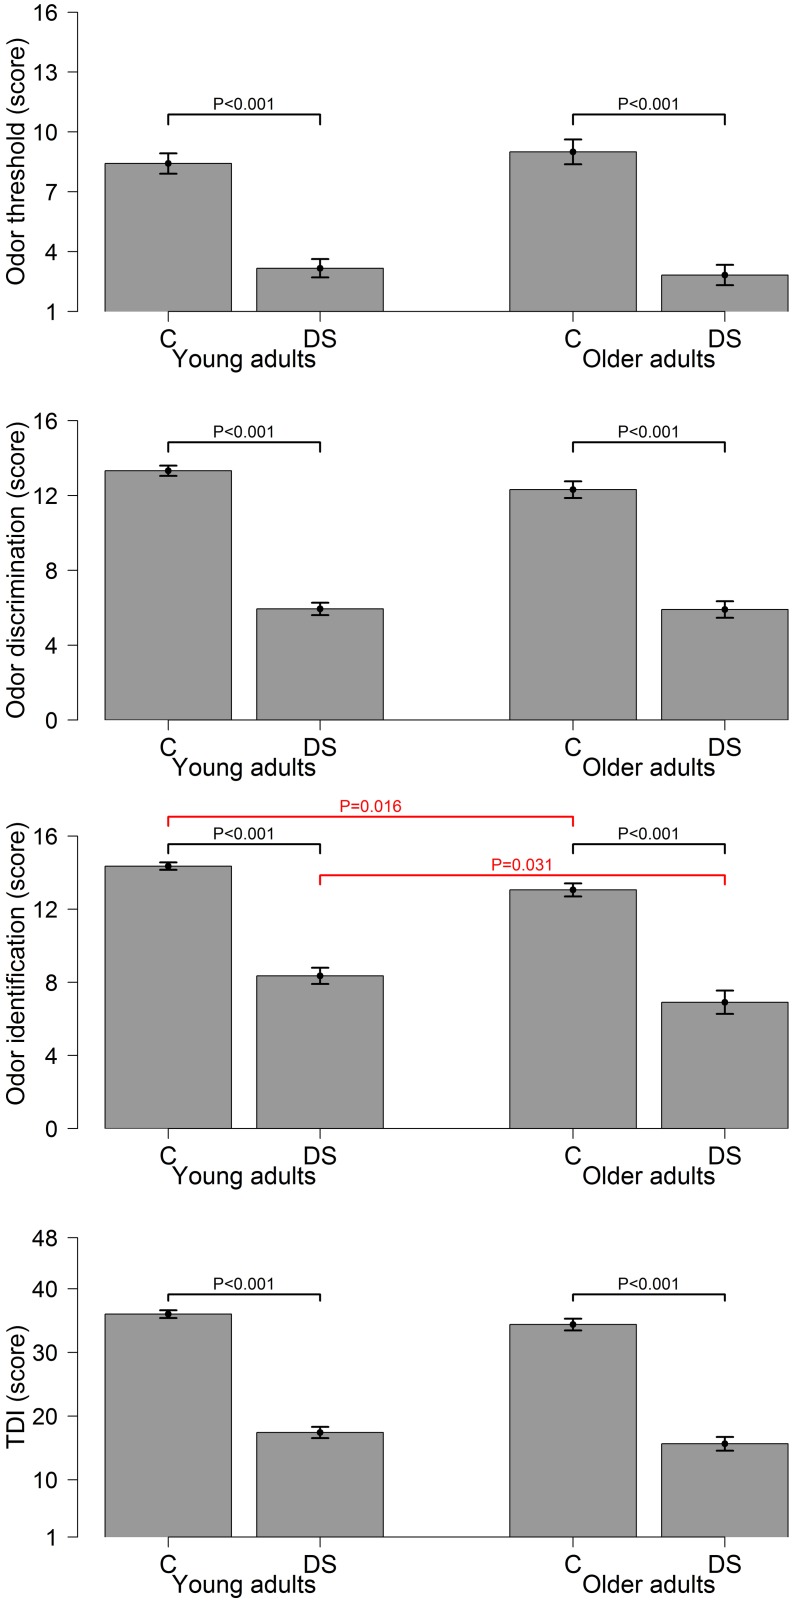
Mean scores (with 95% confidence intervals) estimated for DS individuals (DS) and euploid controls (C) in each olfactory subtest (threshold, discrimination, identification), and the global test (TDI) according to age class (young adult [<30y], left panel; older adult [≥30y], right panel).Olfactory performance (adjusted by sex) was significantly lower in DS than controls for any tasks and TDI in both age classes (P<0.001 for all, black bars). Identification score was significantly higher in young adults than older adults both for controls (P = 0.016) and DS (P = 0.031, red bars).